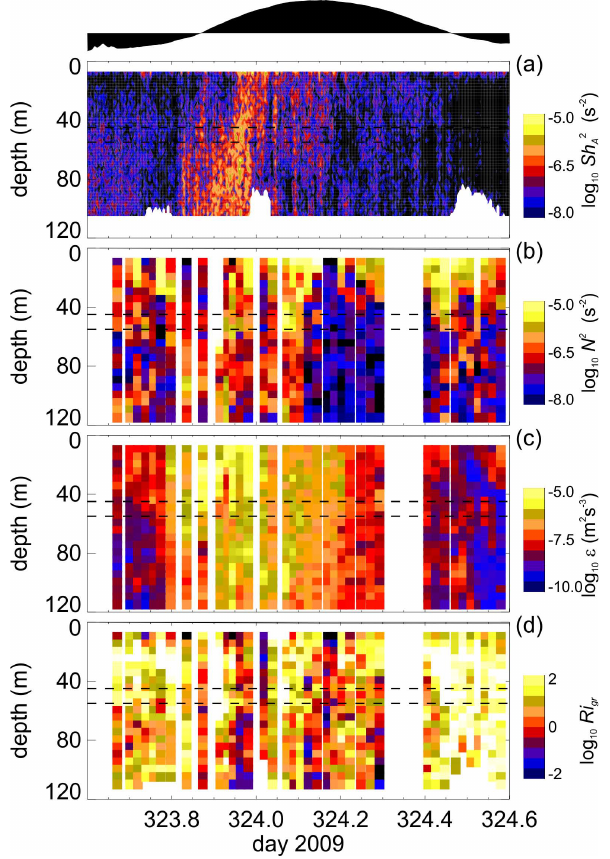
Fig. 8. Calculated properties including (a) ADCP-resolved shear Sh 2 and VMP profiler-resolved (b) buoyancy frequency squared A N 2 , (c) turbulent energy dissipation rate e and (d) the Ri gr as a func- tion of time (NZST = UTC+12). The approximate local depth range of the glacier is shown as horizontal dashed lines. The tidal eleva- tion is shown not to scale above panel (a) . The blank sections at the base of panels (a) and (d) are where there was insufficient backscat- ter to calculate good quality